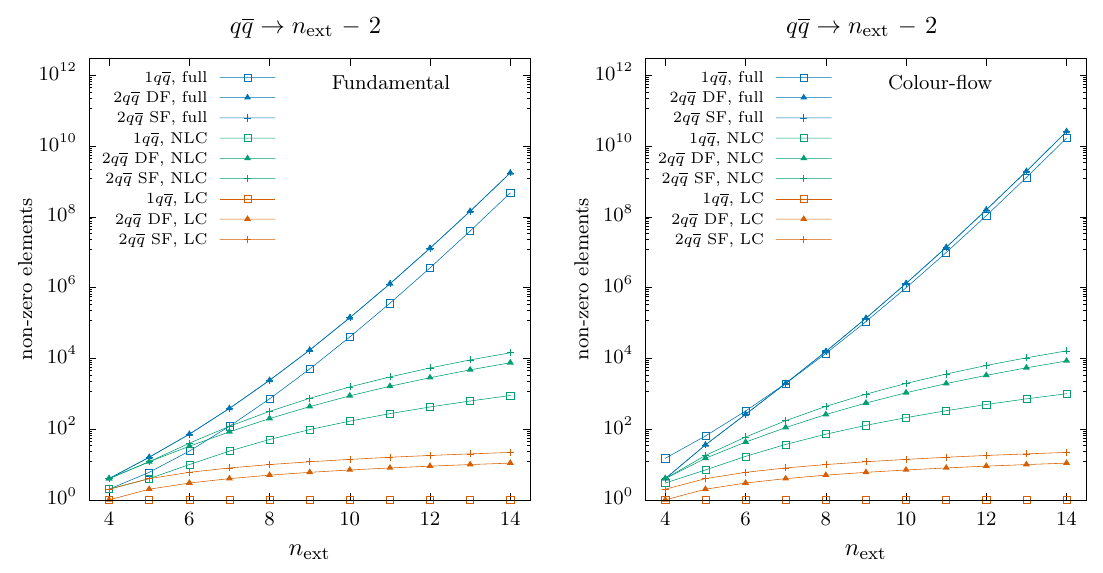
Figure 4 . Number of non-zero elements in the colour matrix at LC (red), NLC (green) and full colour (blue) for qq initial state in fundamental (left) and colour-flow decomposition (right) for various channels: one-quark-pair (box), two-quark-pair distinct-flavour (triangle) two-quark-pair same-flavour